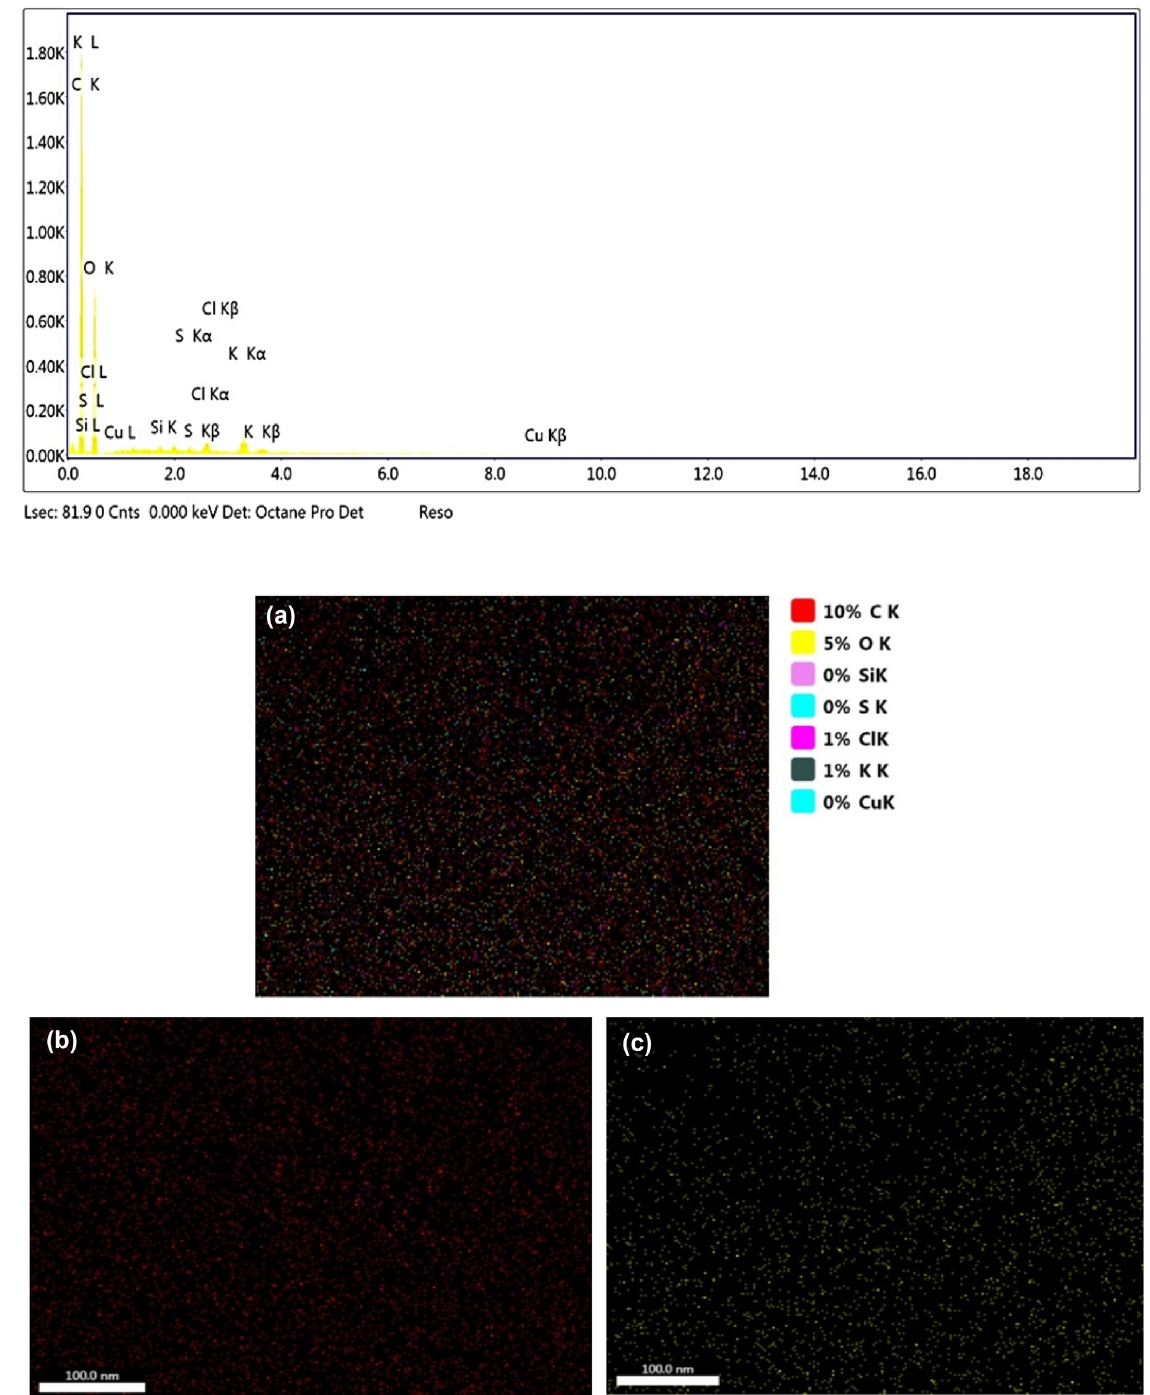
Figure 5. EDS elemental analysis scan of the archaeobotanical material; ( a ) Percentage distribution of all the identified elements; ( b ) C element; ( c ) O element; ( d ) Si element; ( e ) S element; ( f ) Cl element; ( g ) K element; ( h ) Cu